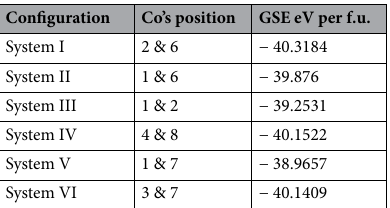
Table 2. Table defining the system I–VI on the basis of cobalt’s position with corresponding ground state energies (GSE).